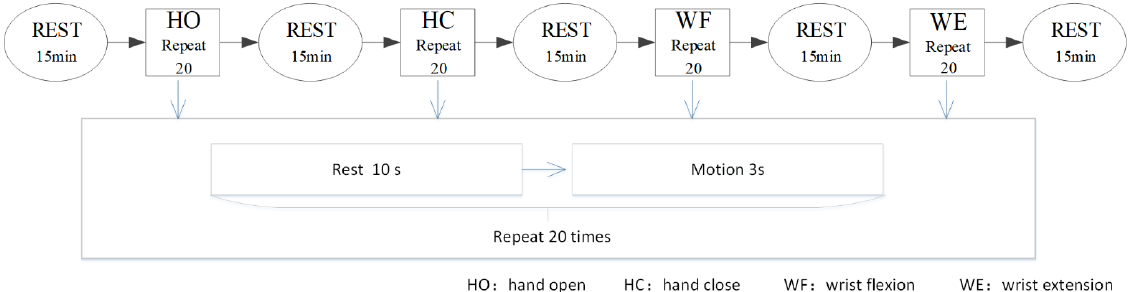
Figure 2. Experimental paradigms. HO: hand open, HC: hand close, WF: wrist flexion, WE: wrist extension.